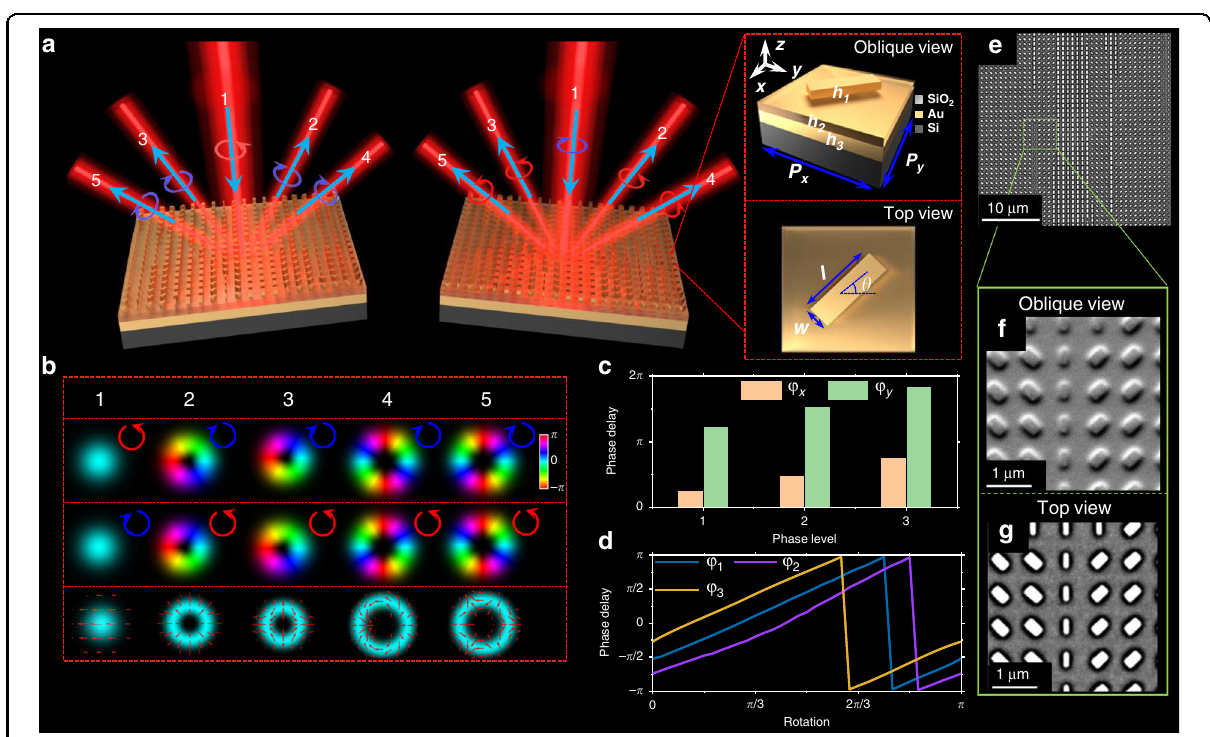
Fig. 2 Design and realization of metasurface-based CVB multiplexer/demultiplexer. a Schematic illustration of generating CVBs, the blue circular arrow represents RHCP, and red is LHCP. The oblique and top views of a unit structure are shown in the red dotted frame, the unit cell dimensions thickness h 1 = 50 nm, and period P x = P y = 800 nm that are deposited on SiO 2 layer with thickness h 2 = 150 nm and Au mirror thickness h 3 = 200 nm. b The light fi eld distribution at each position in a . c Phase of x - and y -direction of the metasurface, here we divide 0 to π into 3 levels. d Calculated phase delay of three size nanoantenna for LHCP beam input. e – g Scanning electron microscopy (SEM) images of fabricated metasurface, e large-scale view, f oblique view, g top view of